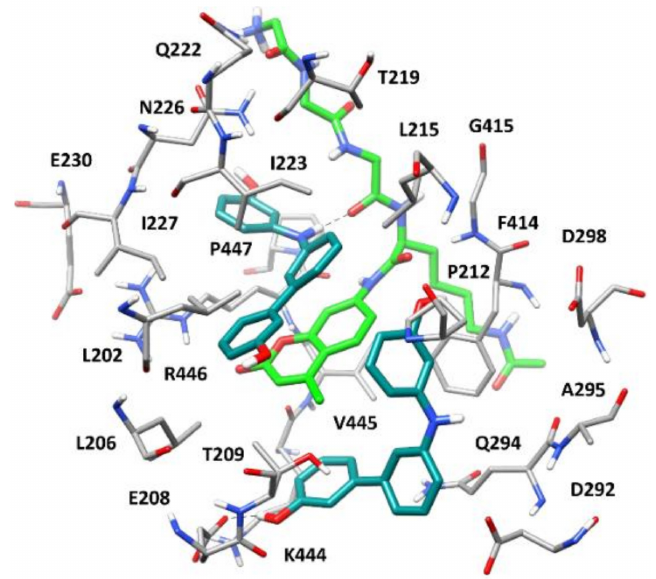
Figure 5. Minimized average structure of SIRT1 in complex with p53-AMC peptide (green) and two molecules of 13 (dark cyan). Ligand–protein and ligand–peptide H-bonds are highlighted as black dashed lines. For clarity, the side chains of R1, H2 and K3 of the of p53-AMC peptide are not